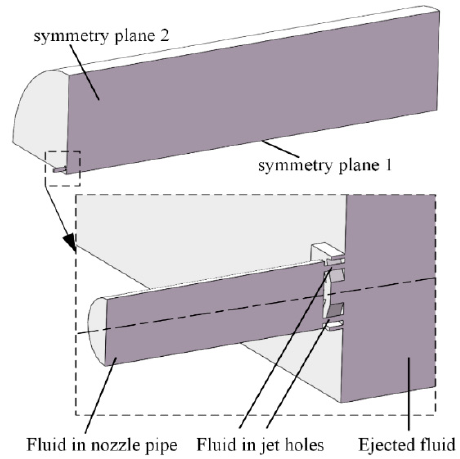
Figure 3. Computational domain of the dual parallel jet with porous nozzles.